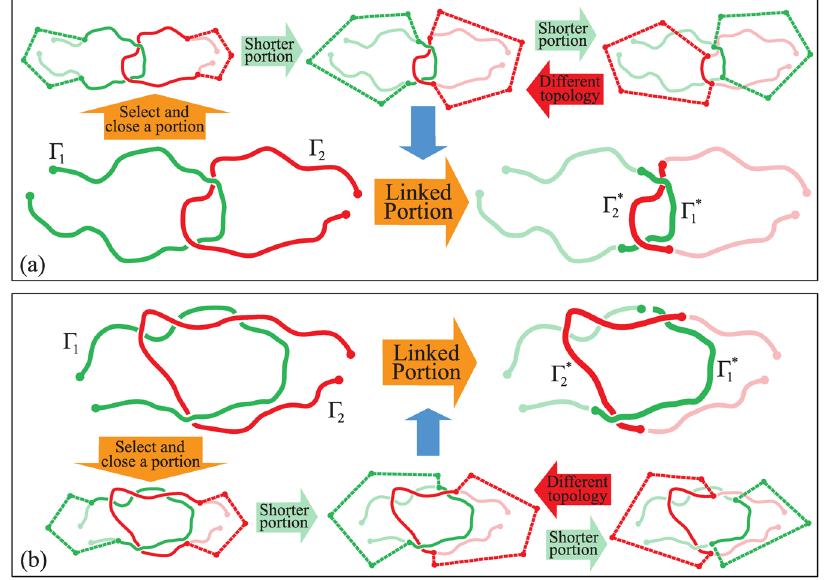
Figure 2. Linked portions of open or closed curves: The linked region of two curves, Γ 1 and Γ 2 is defined as the shortest portion that, upon closure, has the same topology of the original physical link. For open curves, such region can be found by a stochastic top-down reduction of the chains from their termini, as illustrated here. The two panels pertain to physical links with the same topology, the Hopf or 2 12 link, but with large differences for the length of their linked portion, which is indicated with a * subscript in the right part of the panels. For closed chains, the contour reduction can be started from randomly chosen points on the rings, see also Figs S1 and S2 in SI.